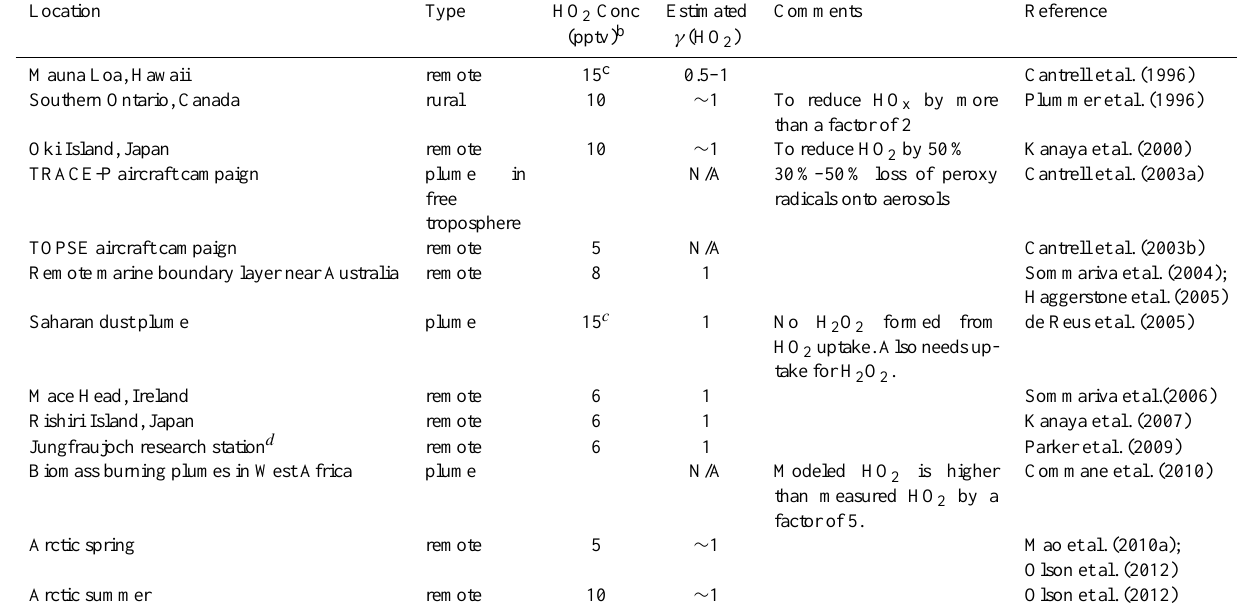
Table 1. Field evidence for HO 2 aerosol uptake a .